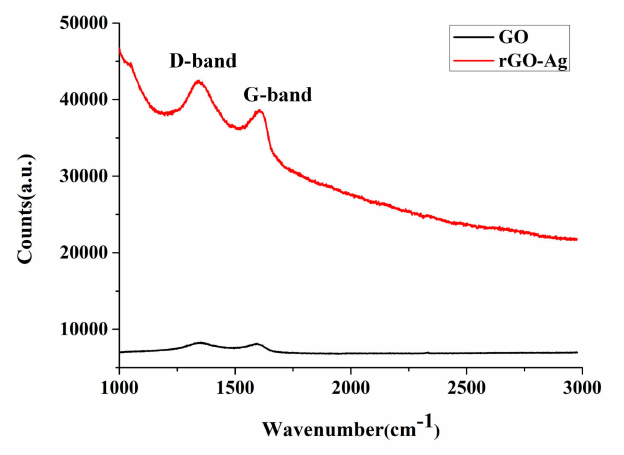
Figure 8. The Raman